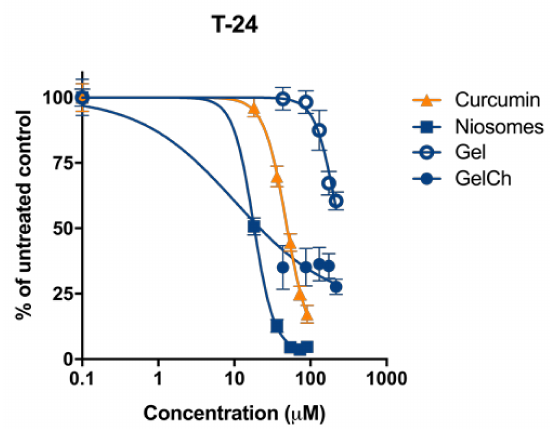
Figure 11. Concentration–response curves of Curcumin and its formulations against T-24 cells evaluated by MTT assay followed 72 h continuous exposure. SD ± represent mean value of 8 independent